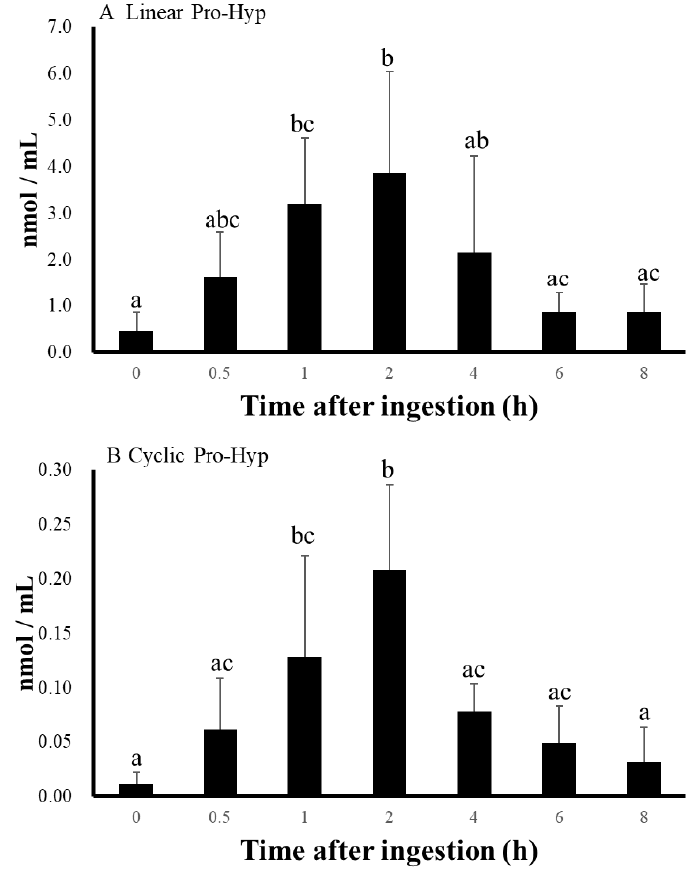
Figure 6. Changes in the average concentrations of linear ( A ) and cyclic ( B ) Pro-Hyp in human plasma of five volunteers. Data are shown as means ± SDs ( n = 5). Different letters adjacent to data points indicate significant differences ( P < 0.05).